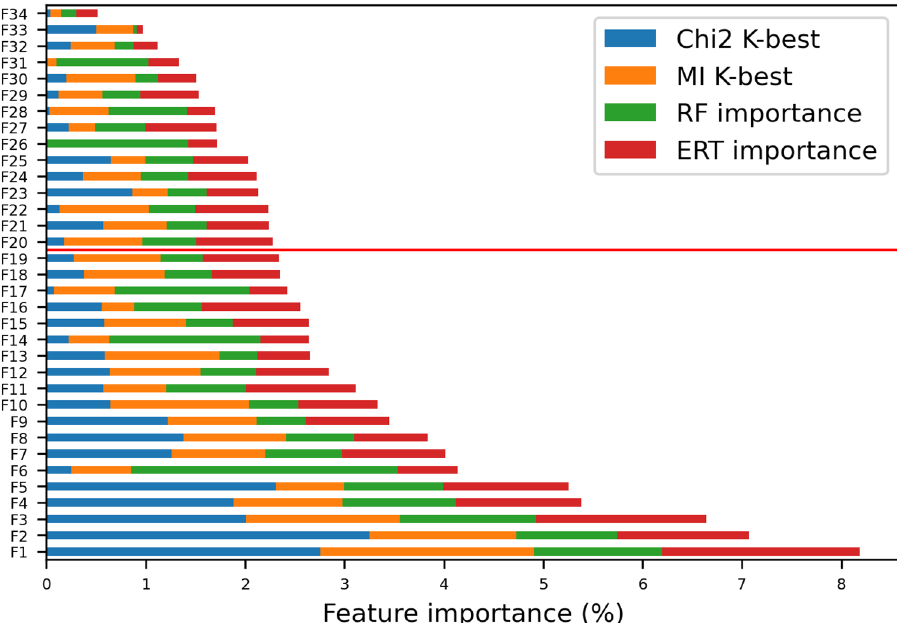
Figure 4. Cumulative feature importance. This graph was obtained by normalizing each feature relevance value by selecting a model for overall relevance and then by sorting the normalized relevance on the considered models. By using this methodology, the best selected features were chosen so that the Cumulative Importance Value (CIV), concerning the overall sum, reaches the value of 75%: the red line divides the selected features from the others. For the description of the features, see Table